Question: Identify the chart type used in this figure.
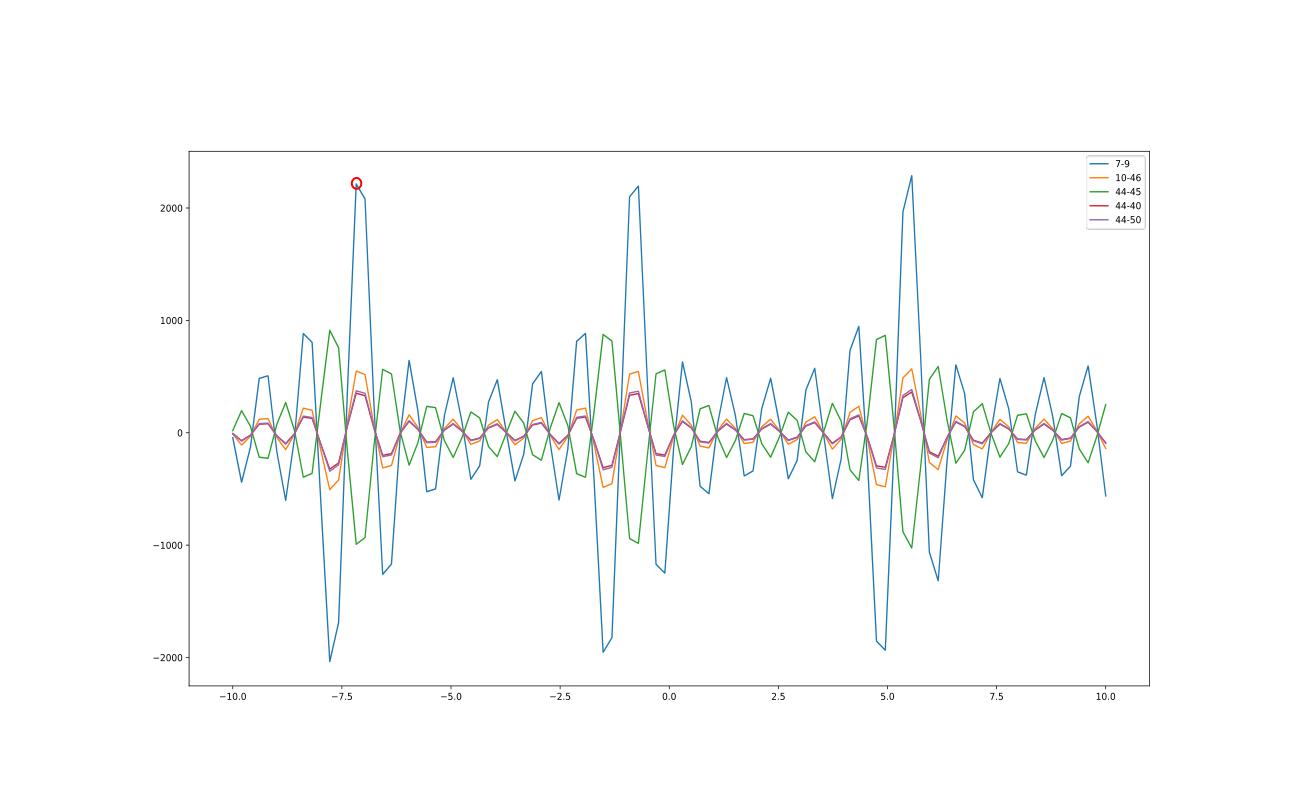
Answer: line